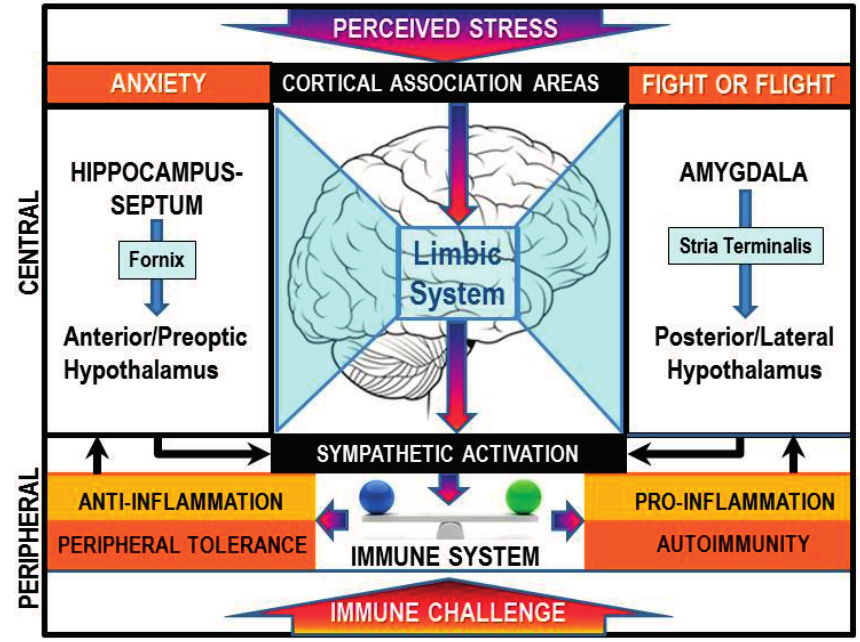
Figure 6. The brain perceives immune stimuli as a stressor via both humoral and via hardwired pathways to the central nervous system (CNS). This information, along with other psychosocial stressors is integrated by cortical association areas, the hypothalamus, and limbic circuits and provides a coordinated stress responses by the two major efferent stress pathways, one of which is the sympathetic nervous system (SNS). The SNS response influences the inflammatory state. Under conditions where the antigen is not eliminated and there is a break in immune tolerance autoimmunity can be